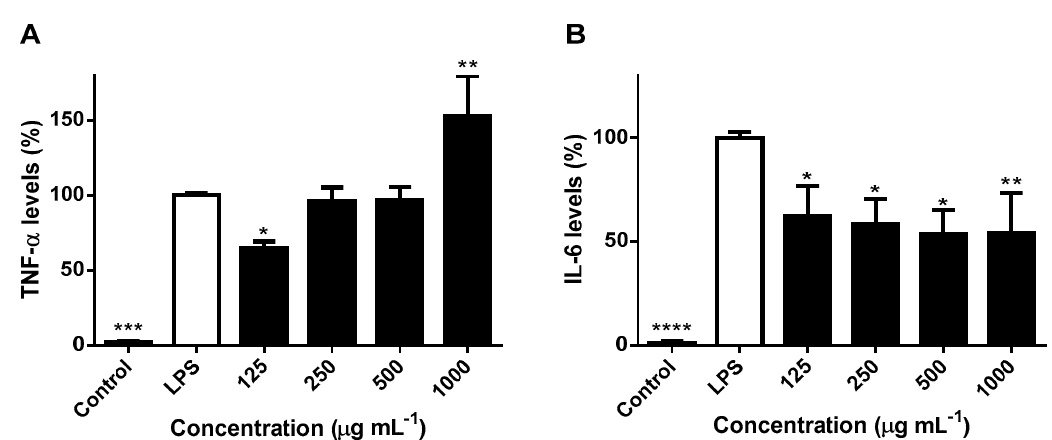
Figure 4. E ff ects of H. bhamoense trunk bark extract on tumor necrosis factor alpha (TNF- α ) ( A ) and interleukin-6 (IL-6) levels ( B ) in LPS-challenged RAW 264.7 cells. Results correspond to the mean ± SEM of three independent experiments performed in triplicate (statistical significance: * p < 0.05, ** p < 0.01, *** p < 0.001 and **** p < 0.0001).